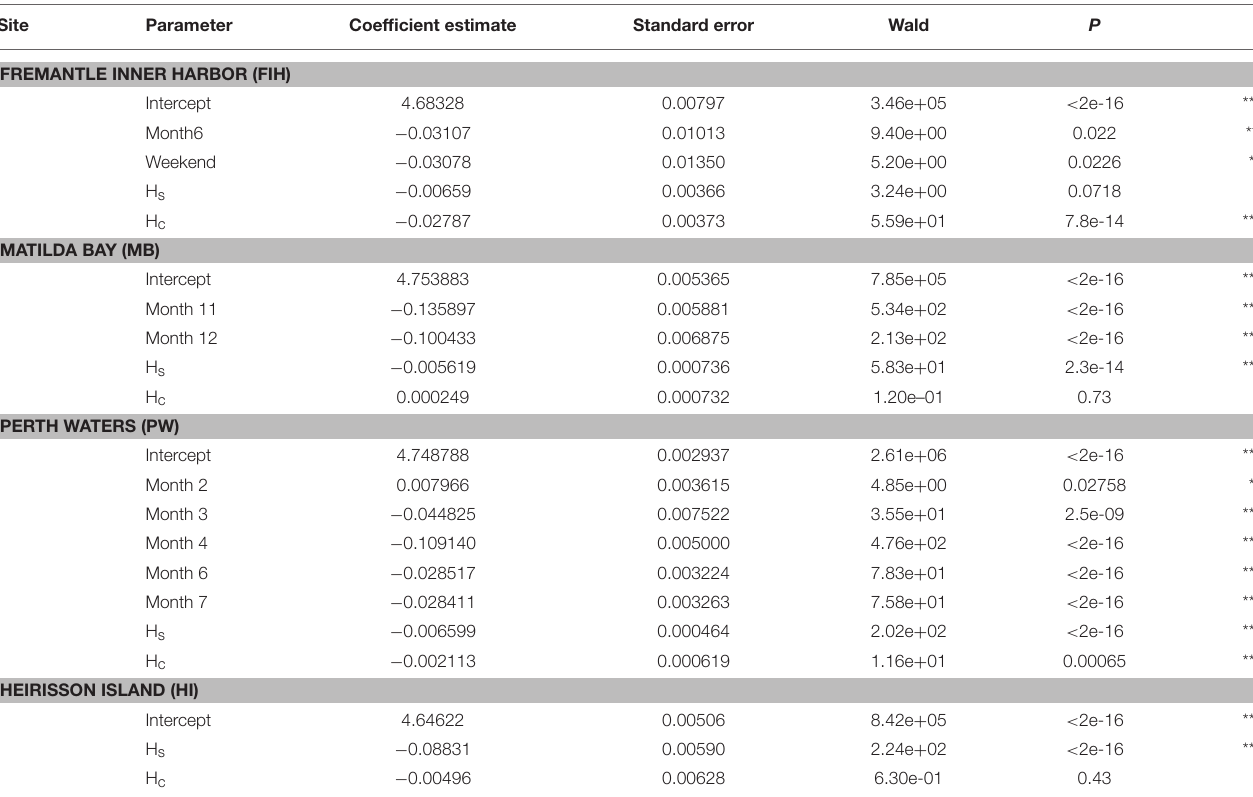
TABLE 2 | Summary of generalized estimating equation (GEE) models investigating temporal patterns within Swan River sites at the scale of Month, DayType (Weekday or Weekend), and Hour (a cyclical variable represented by Hs and Hc ).